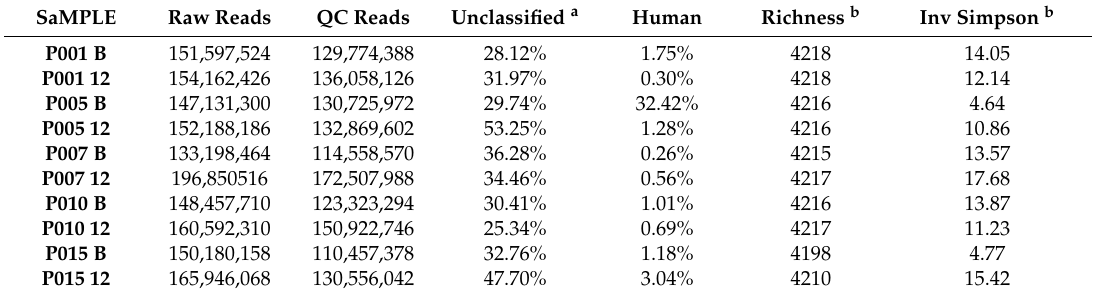
Table 2. The richness and diversity of taxonomic assignments from the metagenomic